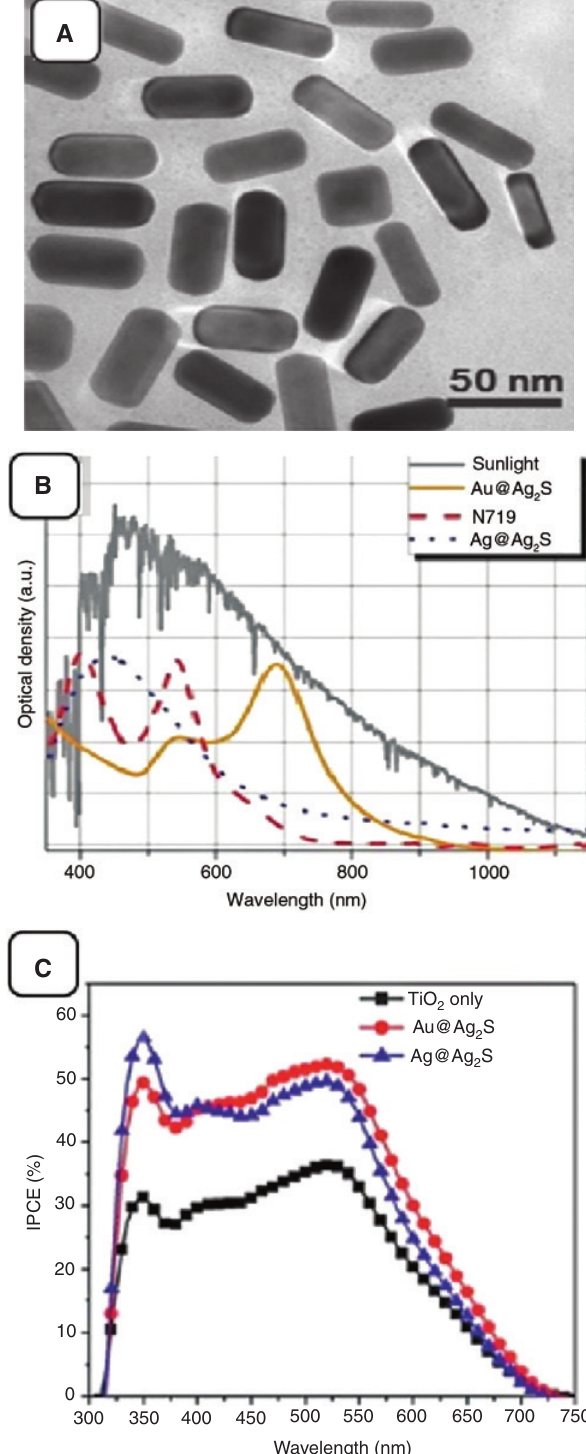
S, (B) Solar Figure 17: (A) TEM image of as-synthesized AuNR@Ag 2 irradiance spectrum, absorption of AuNR@Ag S (2 nm in shell 2 thickness), N719 dye solution in acetonitrile and t-butanol and Ag S- 2 encapsulated Ag nanoparticles, AgNP@Ag S and (C) IPCE (%) of 2 DSCs with Au@Ag S and Ag@Ag S NPs. Reproduced from [94] with 2 2 permission of The Royal Society of Chemistry.